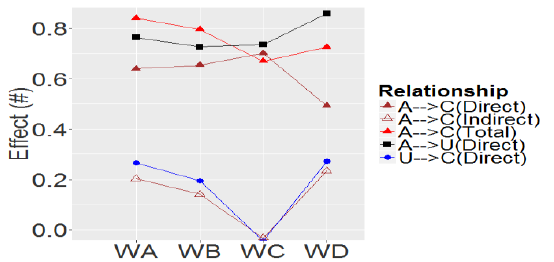
Fig. 5b. Direct, indirect and total effect for the male model